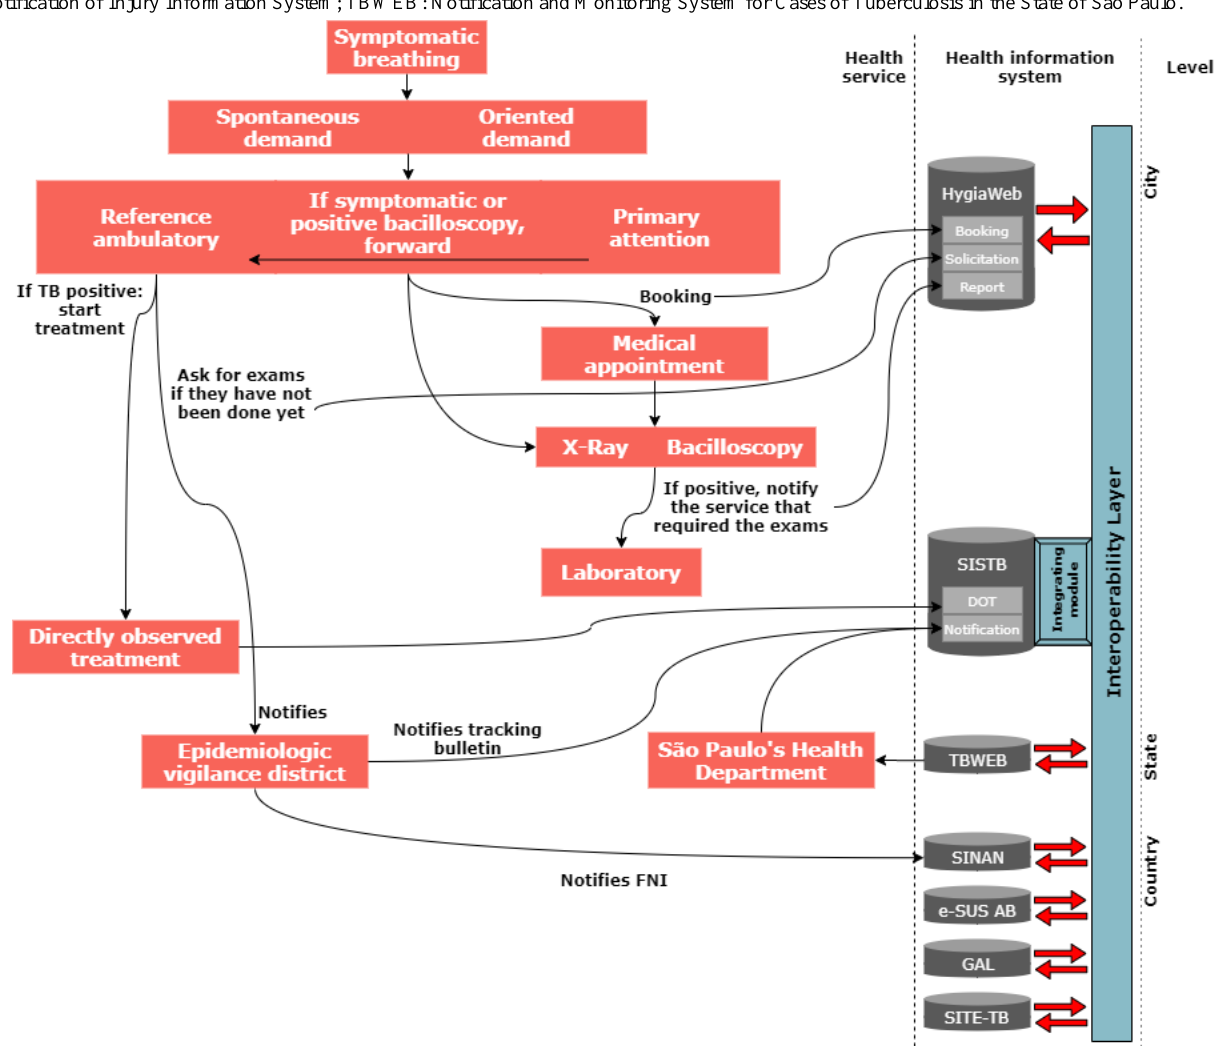
Figure 6. Information flow for tuberculosis treatment after implementation; adapted and improved from [37,38]. DOT: directly observed treatment; e-SUS: electronic Sistema Único de Saúde; FNI: Formulário de Notificação Individual; GAL: sistema Gerenciador de Ambiente Laboratorial;